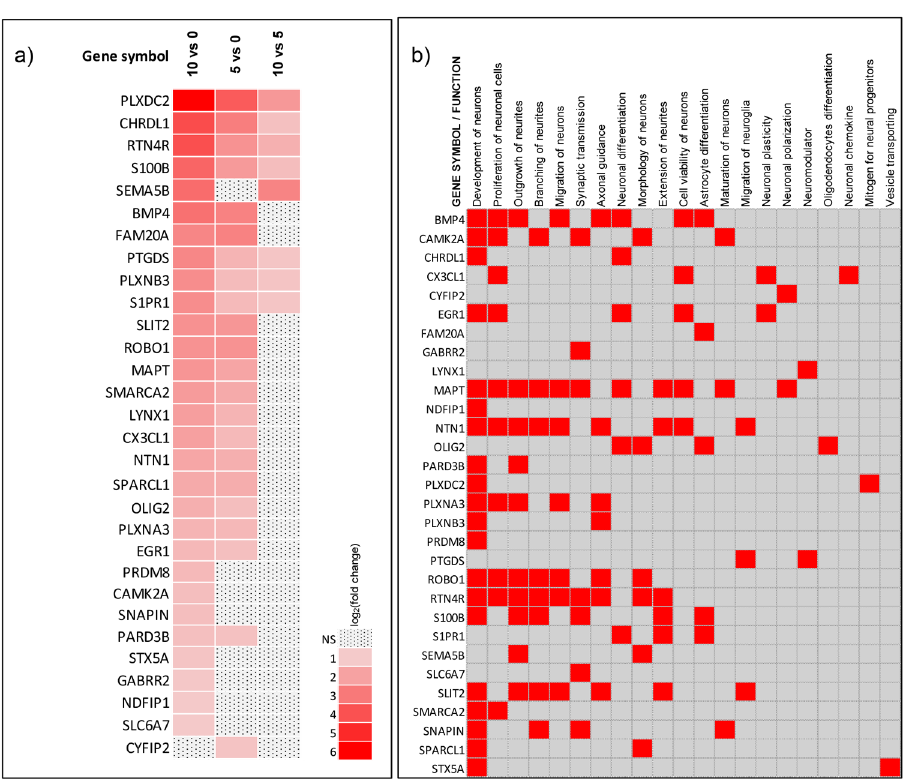
Fig 4. Mapping of the 30 genes selected as important for neural differentiation of the C17.2 cell line. a) Heatmap of the 30 selectedgenes for the contrasts 10 days of differentiation(Day 10) vs undifferentiated cells (Day 0), 5 days of differentiation(Day 5) vs undifferentiated and 10 days of differentiation vs 5 days of differentiation are illustrated. Genes are orderedaccordingto averagelog2(foldchange)in the contrast Day 10 vs Day 0. b) Map displayingthe biological pathways/networks that the selectedgenesare involvedin accordingto the IPA databaseas well as after manualreview of publishedliterature.